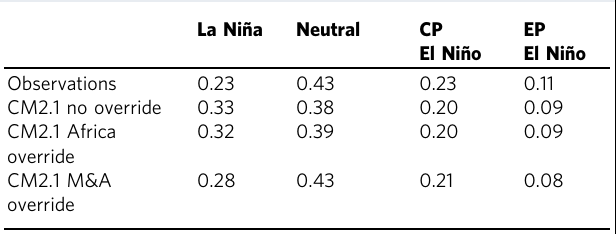
Table 1 ENSO phase probabilities in the observational and model data.